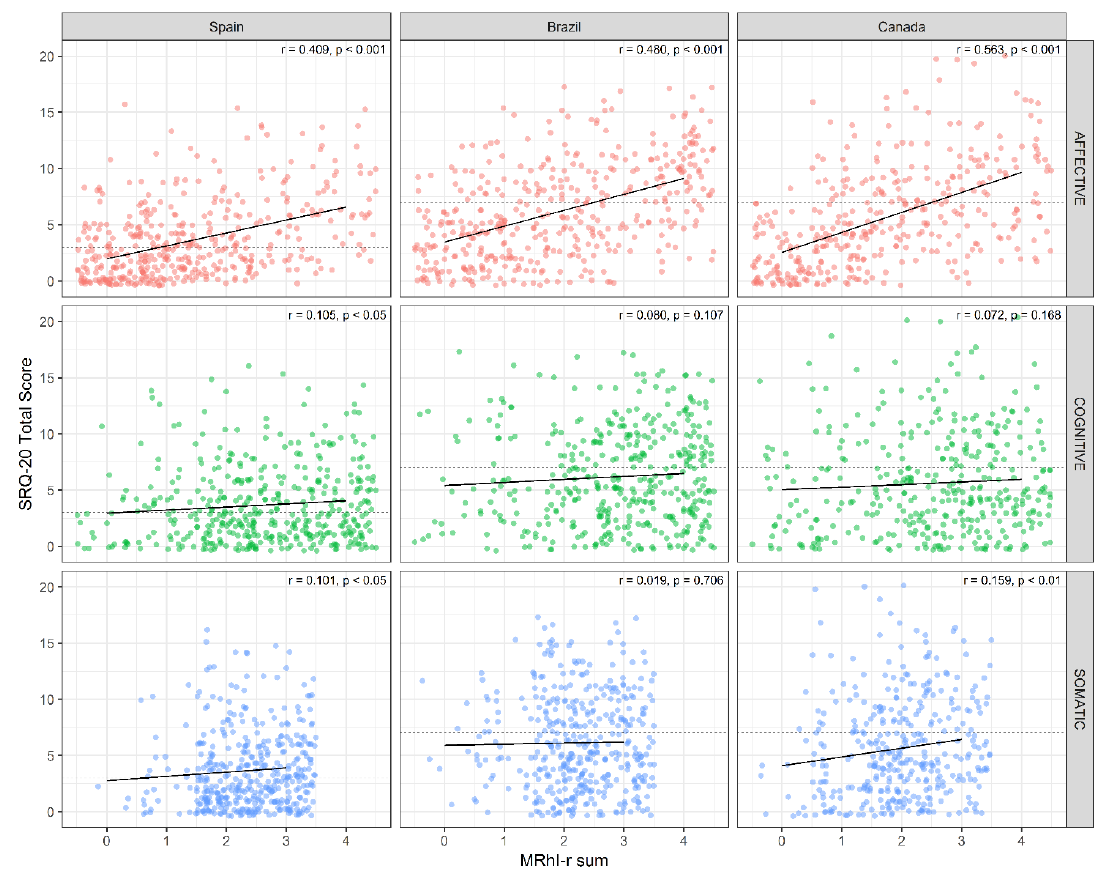
Figure 3. Correlations between the total sum of MRhI-r dichotomous variables (MRhI-r sum) and self-reporting questionnaire (SRQ-20) total scores (SRQ-20 score) separately for domain and country. SRQ cut-offs, which are distinct according to country, are displayed as dashed lines. Only data from participants that completed the entire SRQ were included (Spain-cognitive, n = 417; Spain-affective, n = 418; Spain-somatic, n = 419; Brazil-cognitive, n = 411; Brazil-affective, n = 412; Brazil-somatic, n = 412; Canada-cognitive, n = 367; Canada-affective, n = 367; Canada-somatic, n = 367). The significant correlations were in affective domains for all countries, in the cognitive domain for Spain, and in the somatic domain for Spain and Canada.